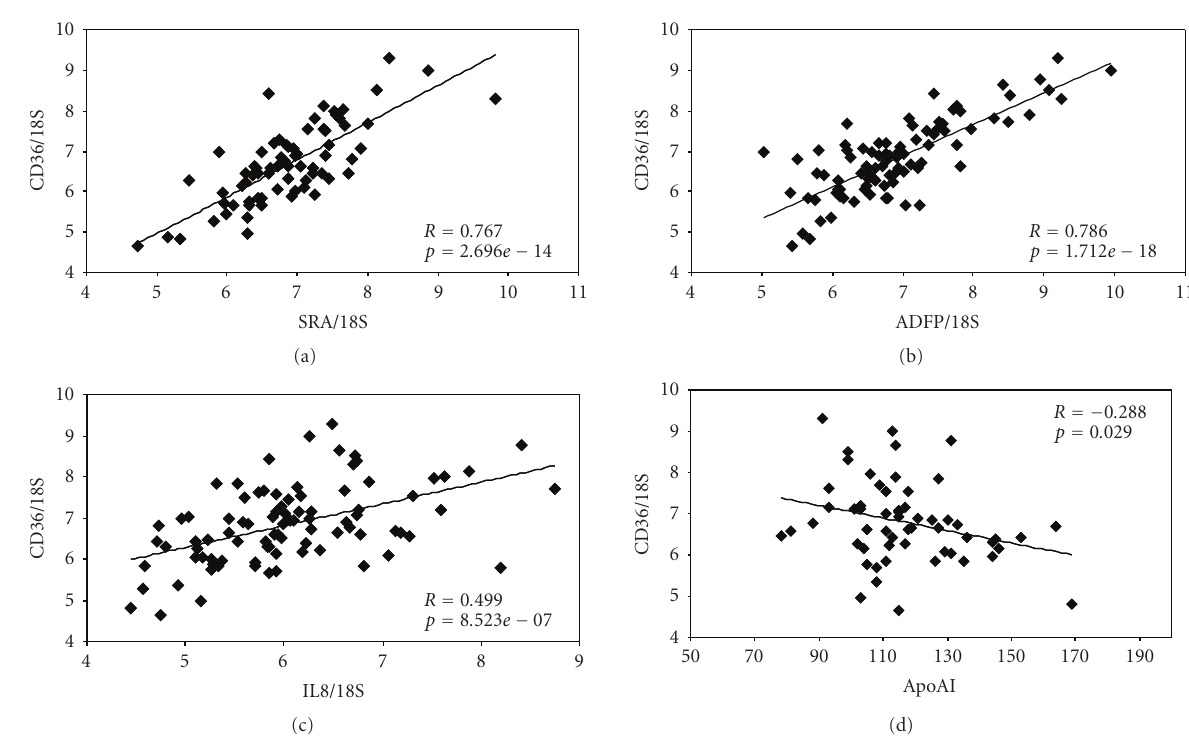
Figure 4: Correlation of CD36 with (a) SRA ( n = 72), (b) adipophilin ( n = 88), or (c) IL-8 ( n = 88) gene expression in plaque lesion area (PLA). (d) Correlation of CD36 gene expression in plaque lesion areas (PLAs) with plasma marker ApoAI level in 57 patients. Pearson’s correlation statistical test was